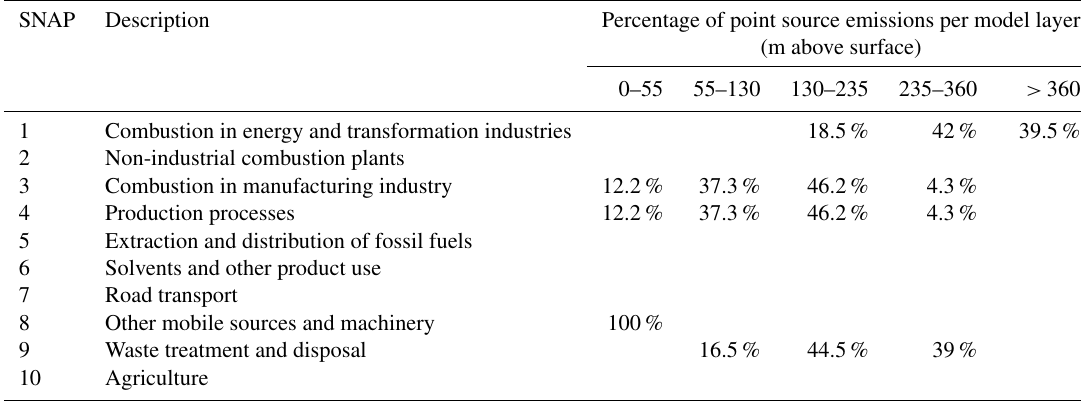
Table 1. Overview of SNAP categories and the vertical distribution of point source emissions in WRF-Chem.